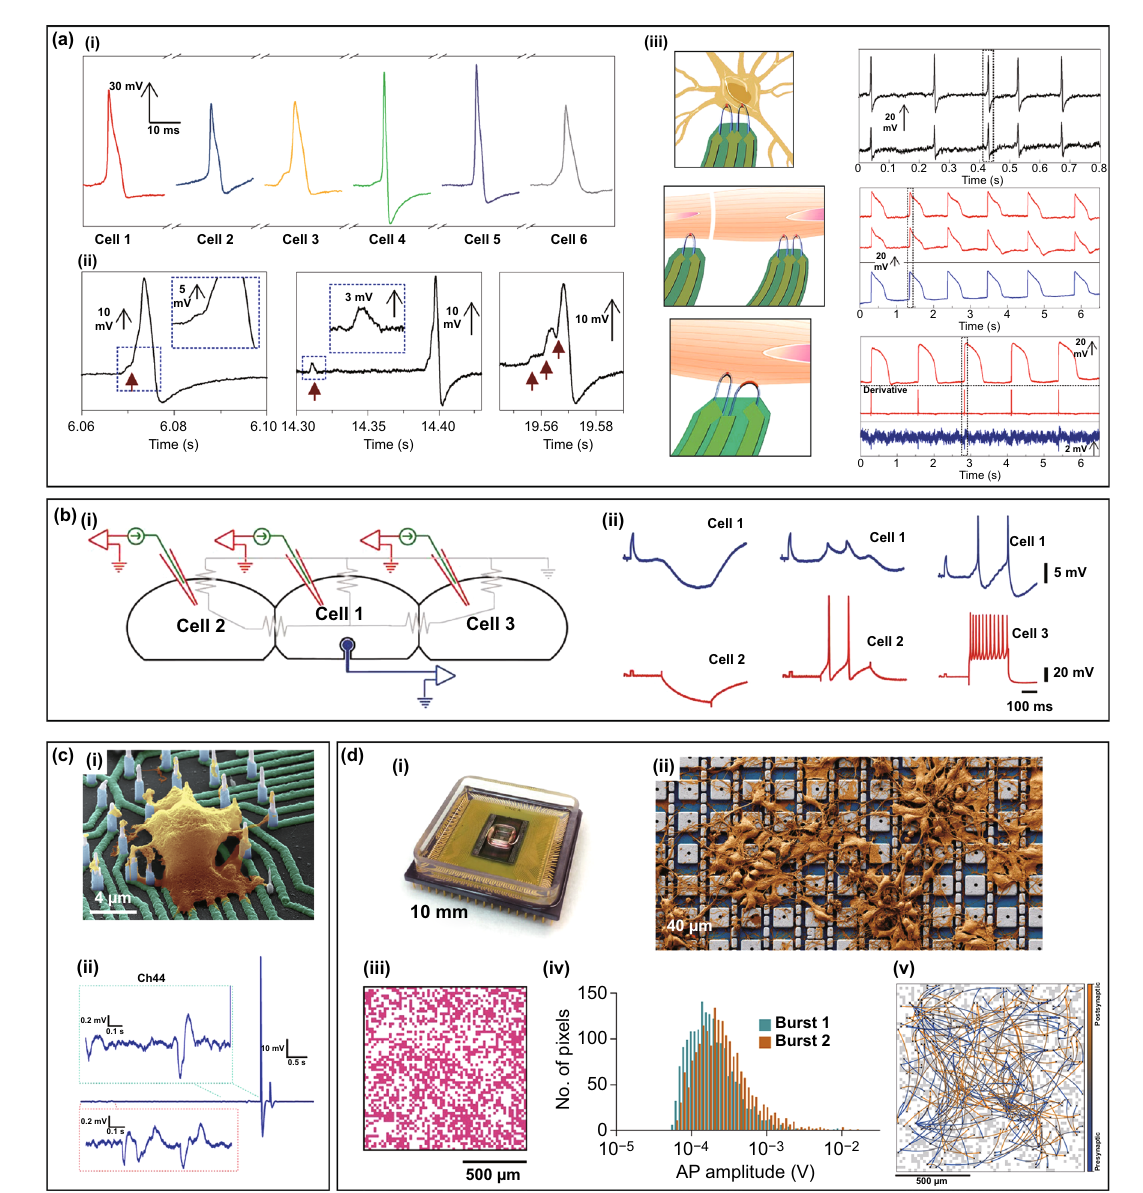
Fig. 6 In-cell nanoelectronics for neurons. a (i) The sequential recording of six independent dorsal root ganglion (DRG) neurons by U-NWFET. (ii) Three different subthreshold activities of DRG neurons measured by U-NWFET. (iii) The multiplexing of U-NWFET. Multiple U-NWFET probes were used to simultaneously measure a single neuron (top), different neurons (middle) and intracellular/extracellular potentials (bottom). Reproduced with permission from Ref. [109]. Copyright 2019, Nature. b (i) Three buccal neurons cultured on FGSEs. (ii) Synaptic potentials recorded from neuron 1 by a FGSE after the depolarizing or hyperpolarizing pulses were applied to neuron 2 or 3. Reproduced with permis- sion from Ref. [97]. Copyright 2010, Nature. c (i) hiPSC-derived cortical neurons cultured on nanowires. (ii) Intracellular recording of a 99 mV action potential and subthreshold oscillations based on the individually addressable nanowire electrode. Reproduced with permission from Ref. [9]. Copyright 2017, American Association for the Advancement of Science. d (i) The device of CMOS-activated 4096 nanoelectrode array. (ii) Neurons cultured on top of the electrode array. (iii, iv) Network-wide intracellular recording of rat cortical neurons with about 44% cells burst (iii) and the median amplitude of ~ 200 μV (iv). (v) 304 synaptic connections mapped by a nanoelectrode array. Reproduced with permission from Ref. [94]. Copyright 2020,